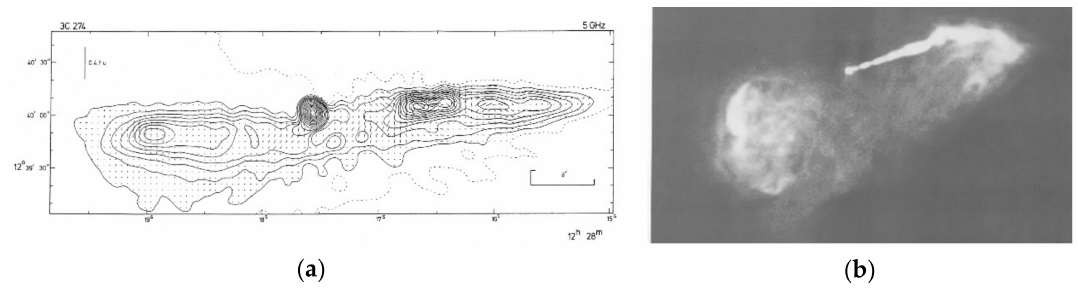
Figure 4. Images of the periphery of a black hole based on measurements: ( a ) M87 visualized with contour lines (from Figure 1, observations of M87 at 5 GHz with the 5 km telescope, Turland, D. B., Mon. Not. R. Astron. Soc., 170) [37]; ( b ) Image of the total intensity of M87 (from Figure 3, Hines,